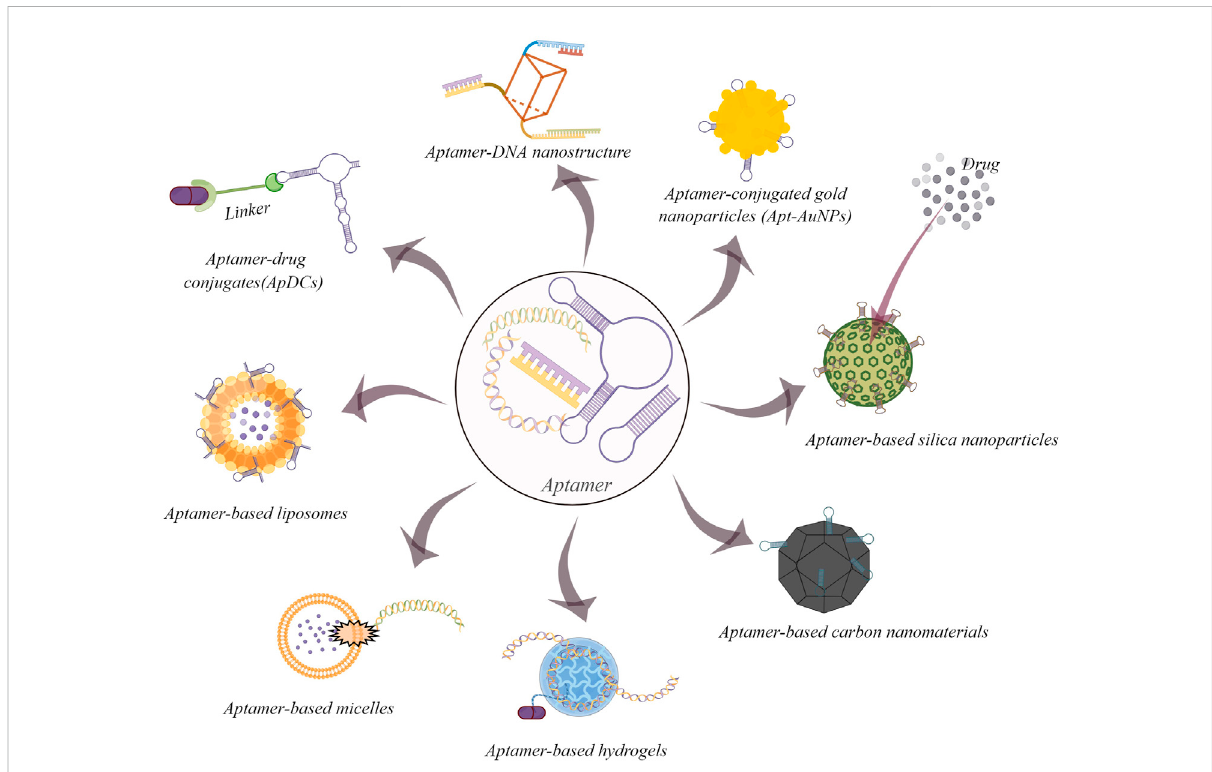
FIGURE 1 Some common examples of aptamer-based drug delivery systems for cancer therapy (By fi